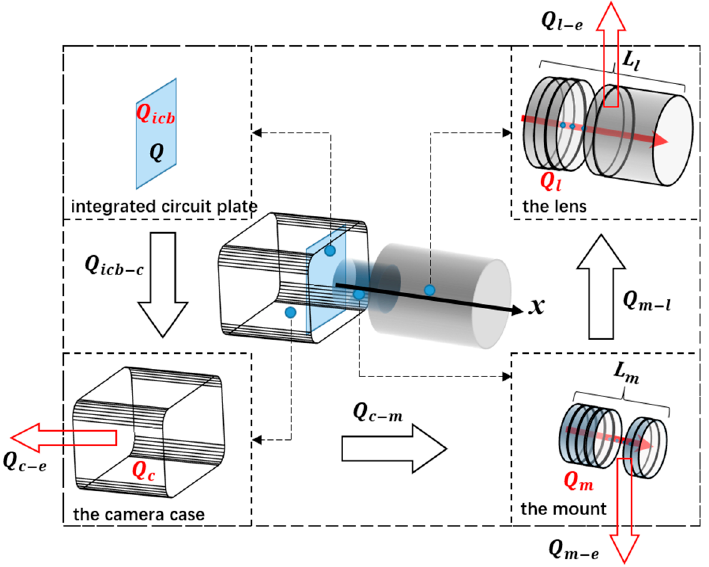
Figure 2. Heat transfer path of a working digital camera system.